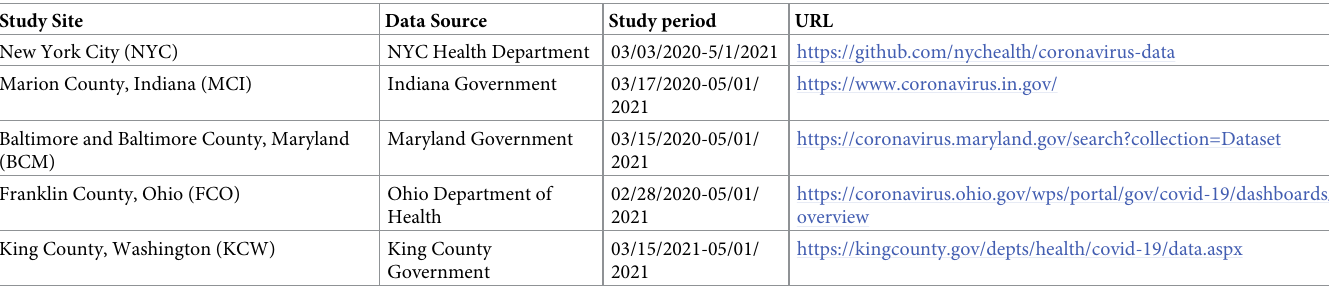
Table 1. Origin of data on daily COVID-19 infections for different study sites. Study